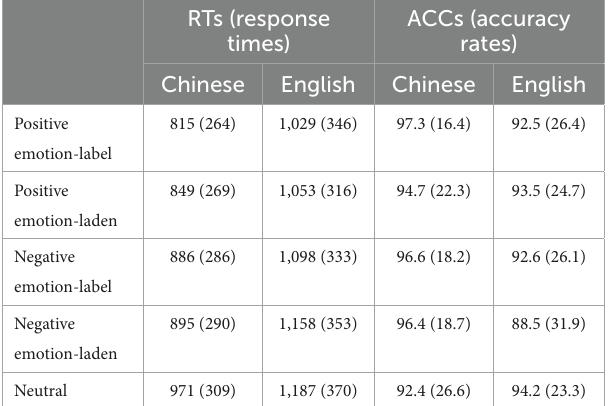
TABLE 3 Mean RTs (ms) and ACCs (%) of five groups of words in L1 (Chinese) and L2